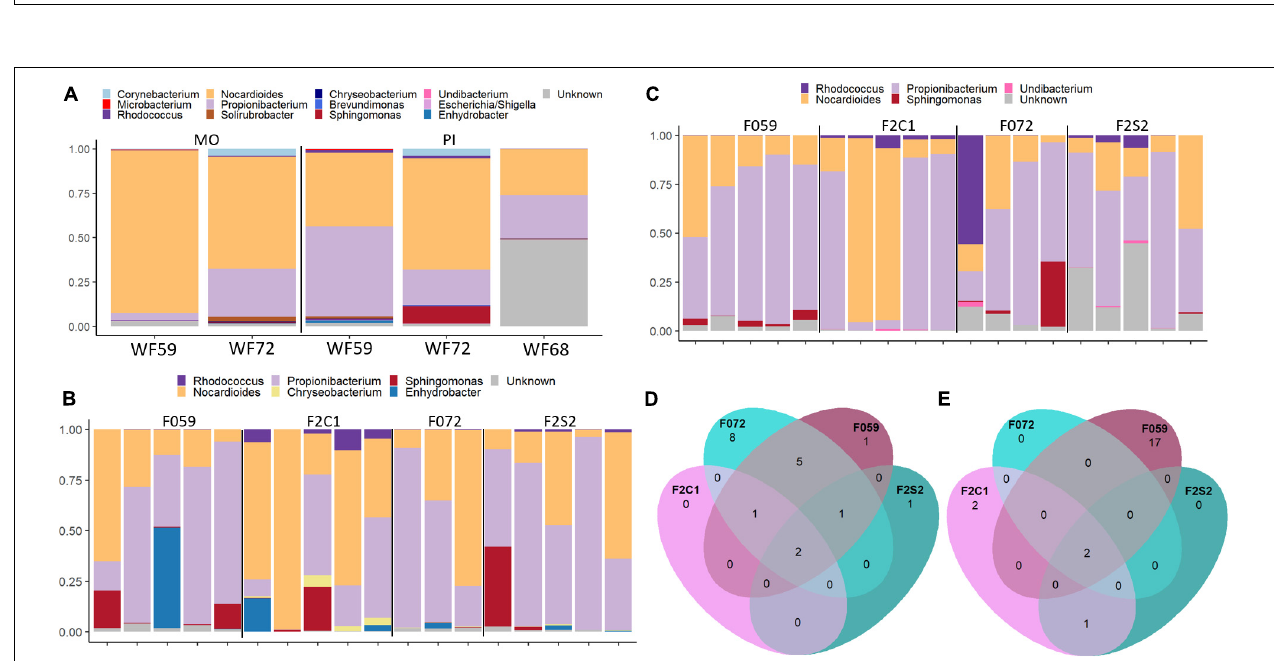
FIGURE 5 | Differences in microbial diversity and composition of mucus bacteria from the buccal cavity and posterior intestine of Nile tilapia from F0 and F2 generations. Chao1, Shannon and Simpson diversities of (A) buccal cavity bacteria, (B) intestine bacteria. PCoA plots of the unweighted and weighted distances associated with (C) buccal cavity bacteria, (D) posterior intestine bacteria. Note that in panel (C) , the ellipse is not drawn for F072 because there were only three samples for this group. F0 generation: F059, F072 and F2 generation: F2C1, F2S2.